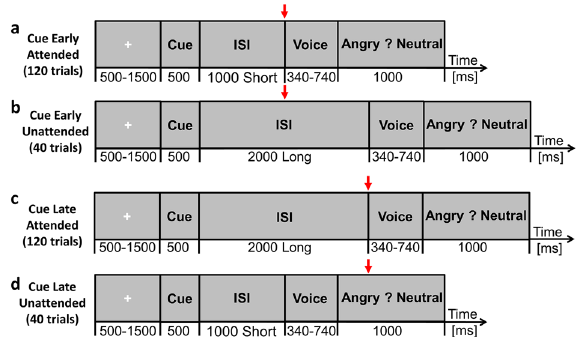
Figure 1. Schematic representation of the emotional recognition task. ( a ) Early attended trials, with short inter- stimulus interval (ISIS). ( b ) Early unattended trials, with long ISIS. ( c ) Late attended trials, with long ISIS. ( d ) Late unattended trials, with short ISIS. Red arrows indicate when the subjects expect the